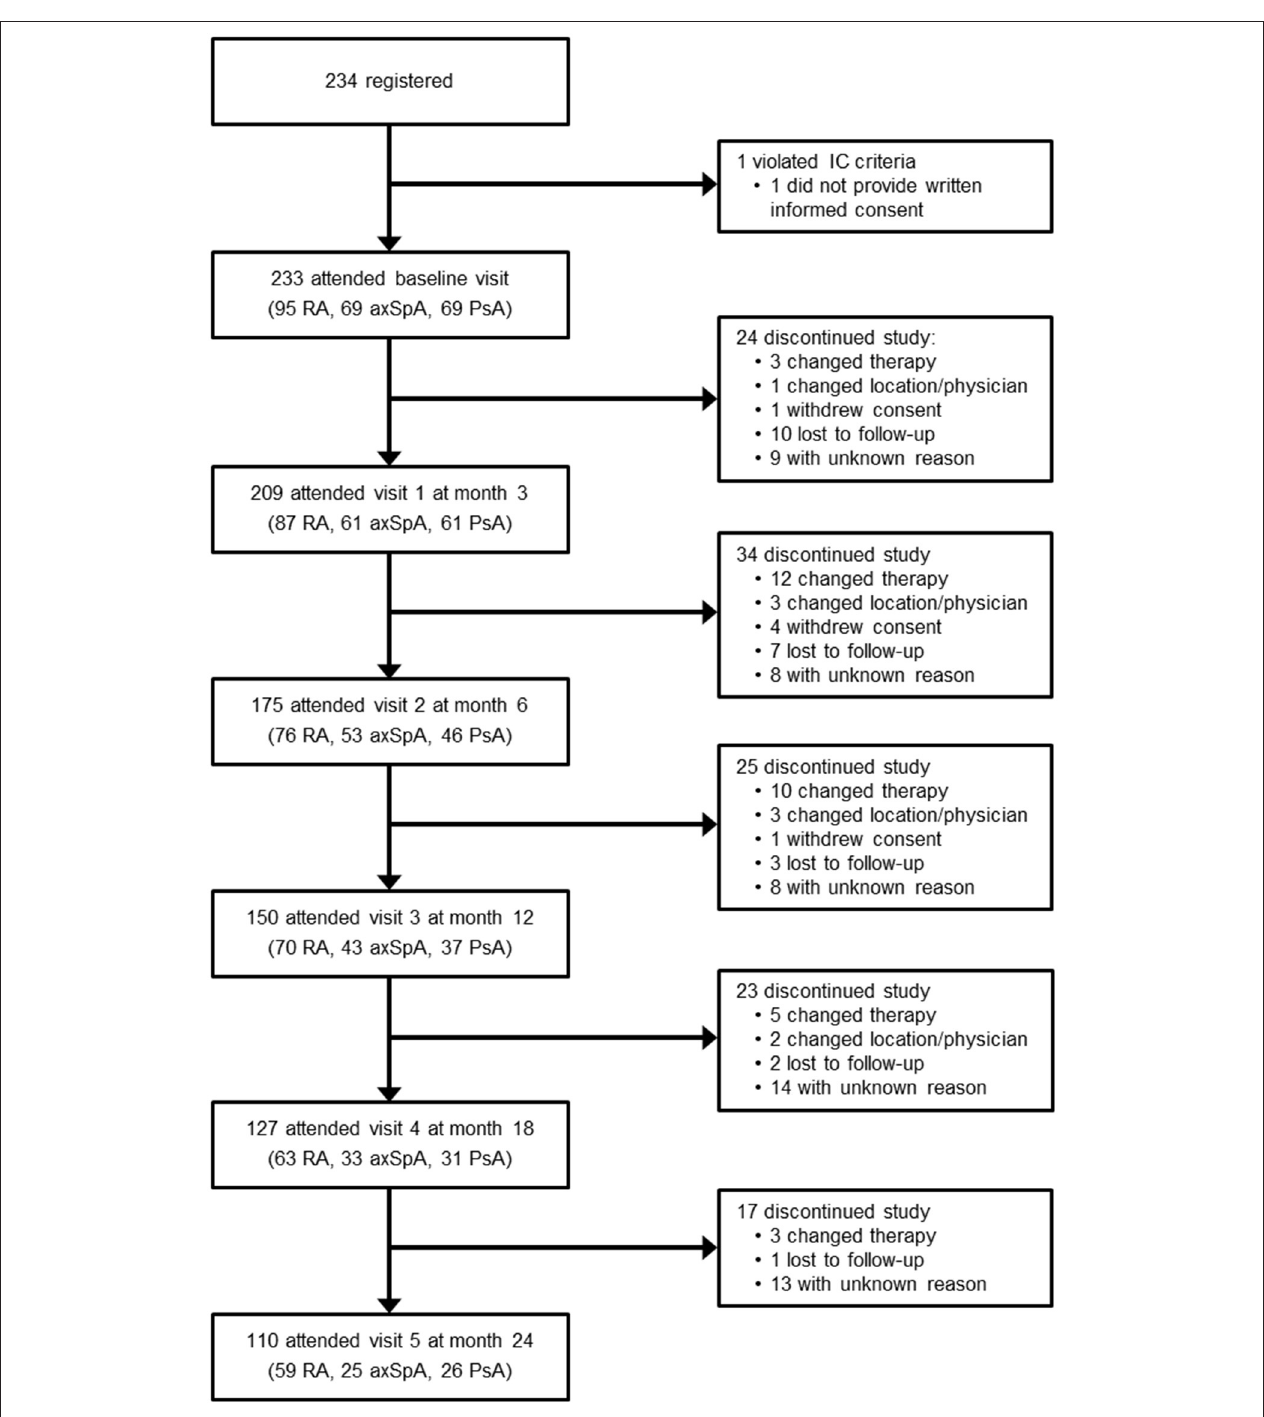
FIGURE 1 | Consort